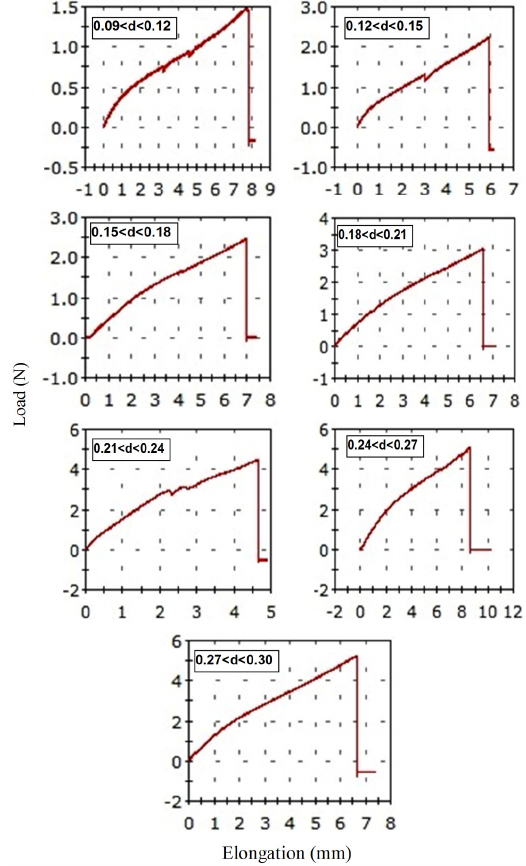
Figure 2. Histogram of the frequency of equivalent fique fiber diameter for the seven conventionally established intervals. Source: authors.